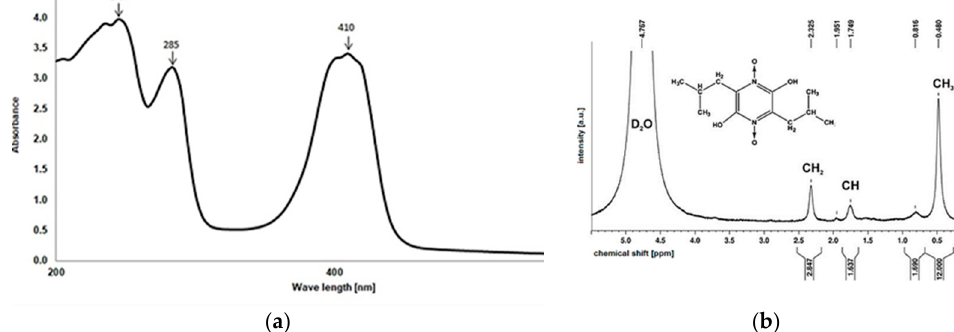
Figure 1. Pulcherrimin spectra: ( a ) spectrophotometry with the maximum absorption at three characteristic wavelengths: 240, 280 and 410 nm; ( b ) 1 H NMR spectroscopy with the characteristic signals of CH 3 , CH 2 and CH, belonging to isobutyl groups; the large solvent peak is typical for analyses carried out for solutions in D 2 O.